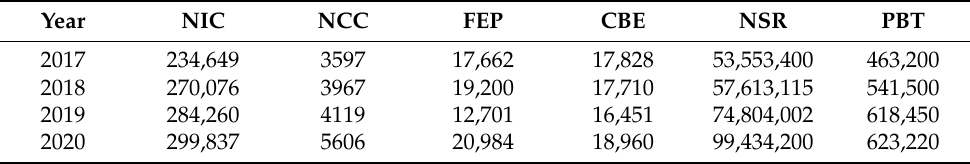
Table 1. Data from 2017 to 2020 (Financial Report 2021).